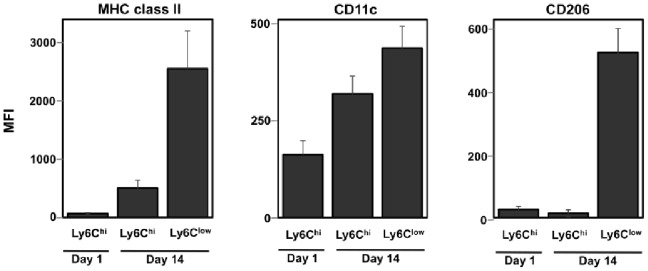
Surface marker expression on day 1 and day 14 wound macrophage subsets.C57BL/6J mice were wounded for 1 or 14 days, and the surface expression of MHC class II, CD11c and CD206 on wound monocyte/macrophage subsets was determined by flow cytometry. Wound monocyte/macrophage subsets were defined as F4/80+Ly6Chi (Ly6Chi) and F4/80+Ly6Clow (Ly6Clow). Mean fluorescence intensities (MFI; geometric mean) were calculated and are presented as the mean ± SD, n = 4 mice per group. Data are representative of at least 3 independent experiments.